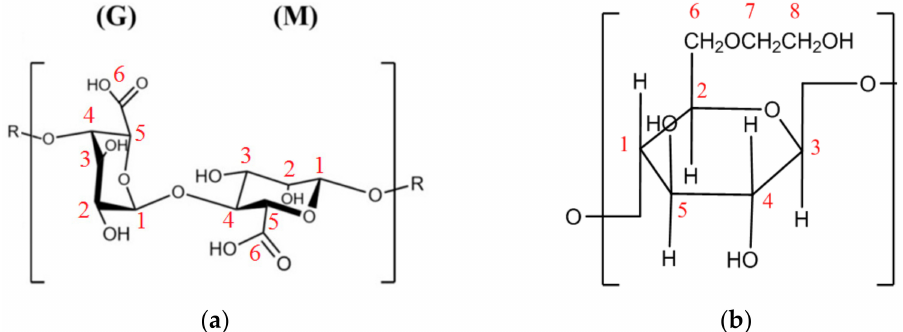
Figure 5. Schematic representation of ( a ) alginate with the blocks of munnuronate (M) and guluronate (G), and ( b ) hydroxyethyl